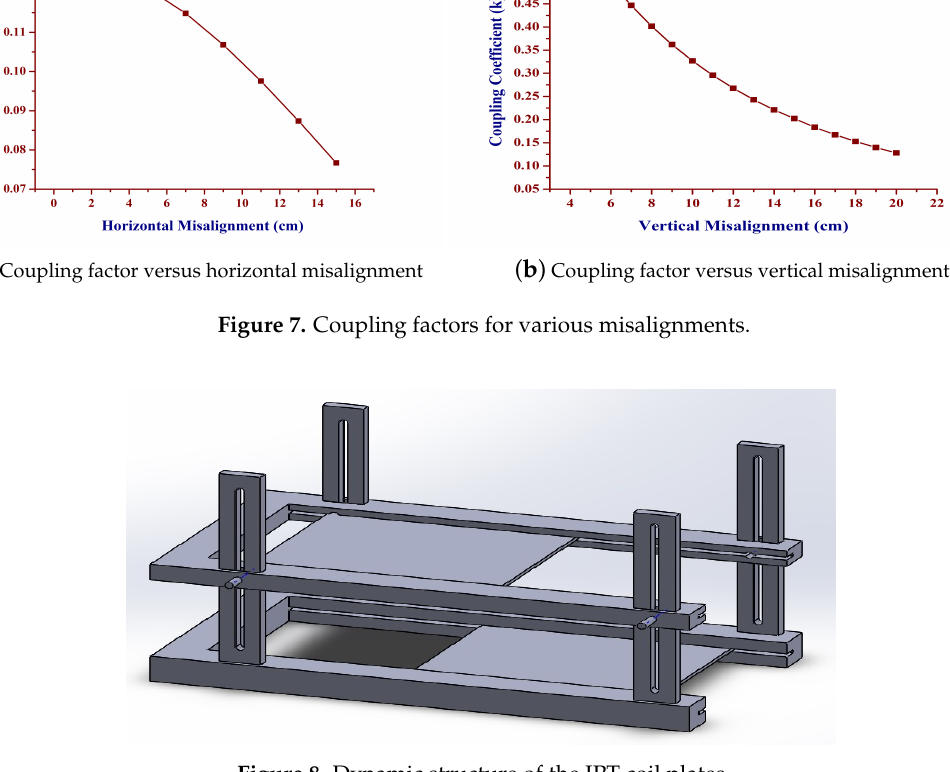
Figure 8. Dynamic structure of the IPT coil